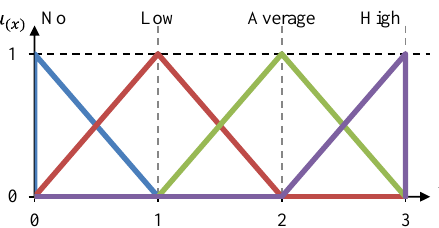
Figure 4. Spaces for linguistic variables illustrating the significance / influence of a system element, based on [29].